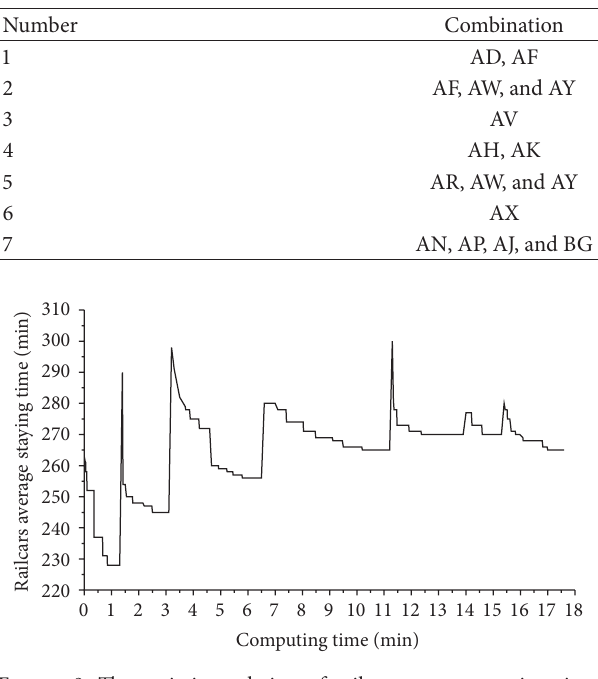
Figure 9: The variation relation of railcars average staying time along with the computing